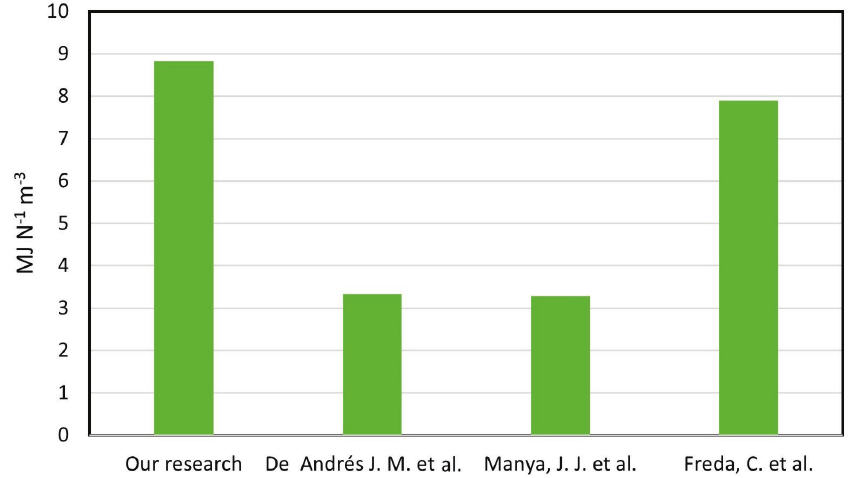
Fig. 3 – Comparison of LHV value of syngas from gasification of SS Zagreb with experimental data from